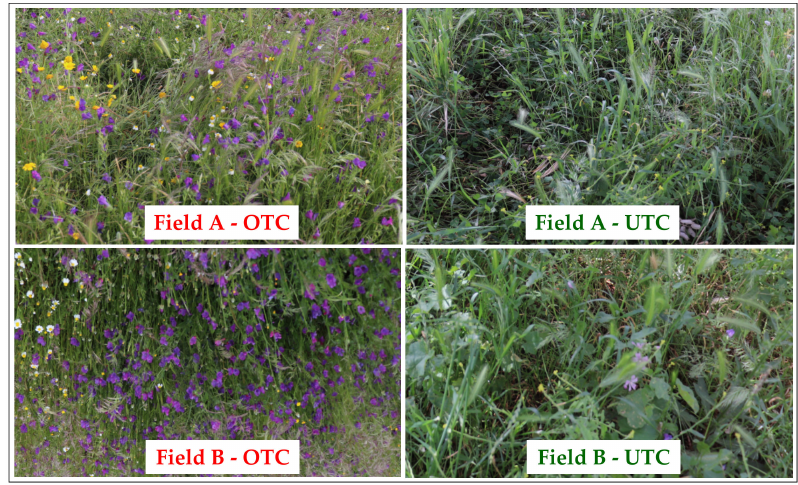
Figure 12. Picture of pastures in sampling areas of the two fields (“Field A” and “Field B”), UTC and OTC in May–June 2021.